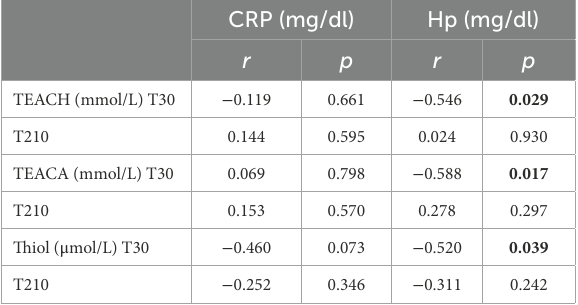
TABLE 5 Coefficients of correlation between serum biomarkers of antioxidant capacity (TEACH, TEACA and Thiol) and serum inflammatory markers (CRP and Hp) in obese dogs ( n = 16) before (T30) and after (T210) caloric restriction (phase 2 of the